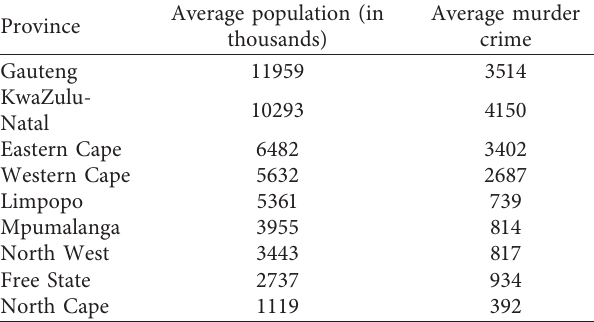
Table 3: Average statistics (population and murder crime) in South Africa per province over a ten-year period—2005 to 2015.